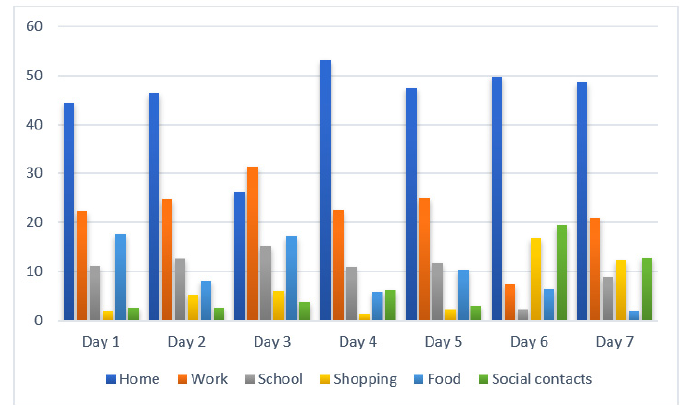
Figure 6. Day wise percentage of trips by trip purpose.